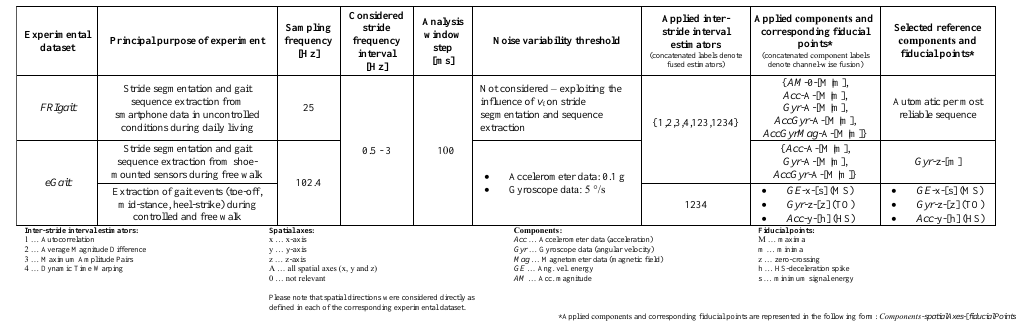
Figure 4. Experimental parameters used for evaluation of the proposed approach on FriGait and eGait